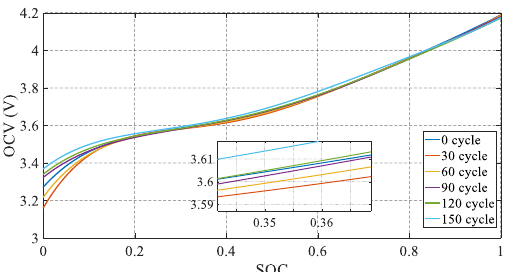
Figure 3. The relationship curve of the open circuit voltage (OCV) and state of charge (SOC) at different aging stages.